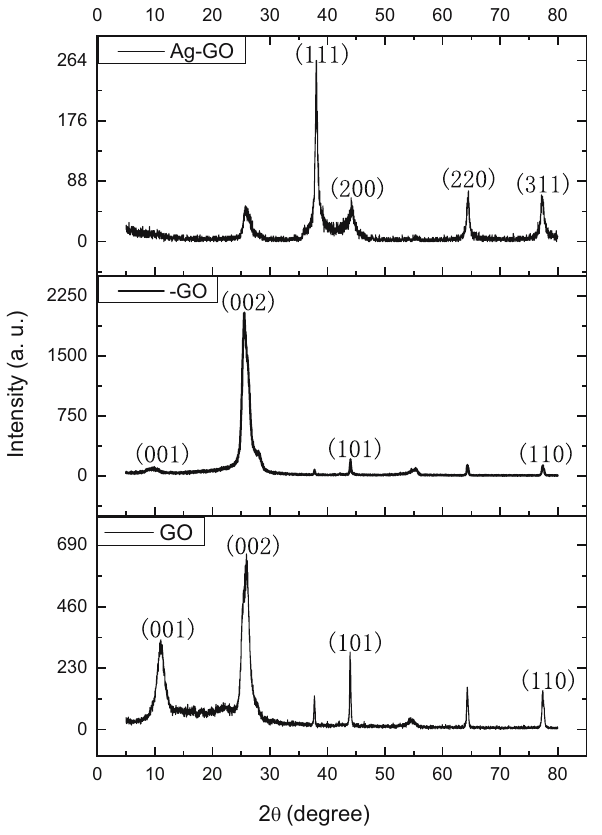
Figure 4: XRD of GO with di ff erent